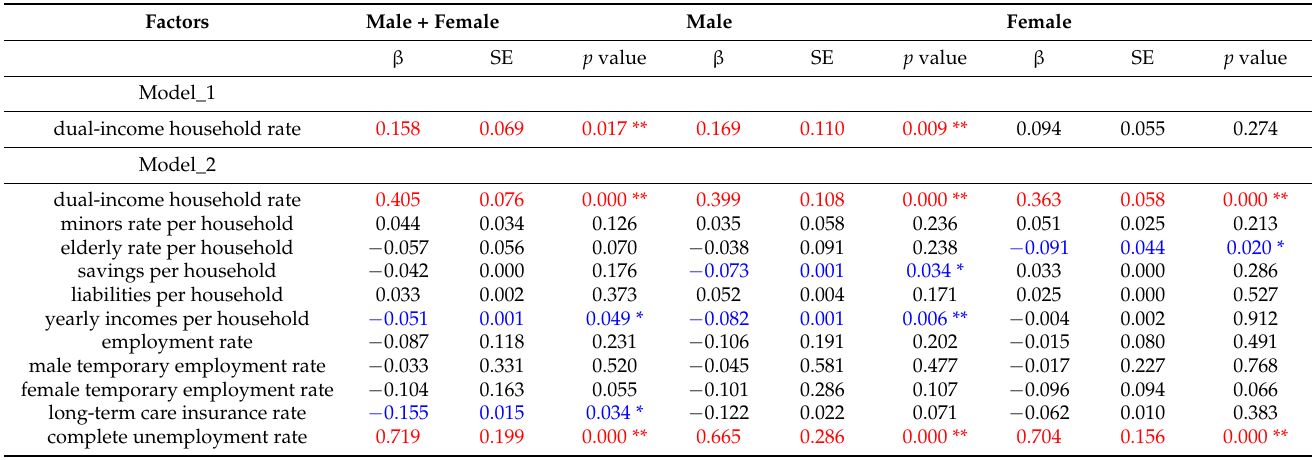
Table 1. Impacts of dual-income household rate (Model_1), household structural and social/employment factors (Model_2) on standardised death rates for suicide mortalities (SDR) of Male + Female, Male and Female between 2009 and 2017. Factors Male + Female Male Female β SE p